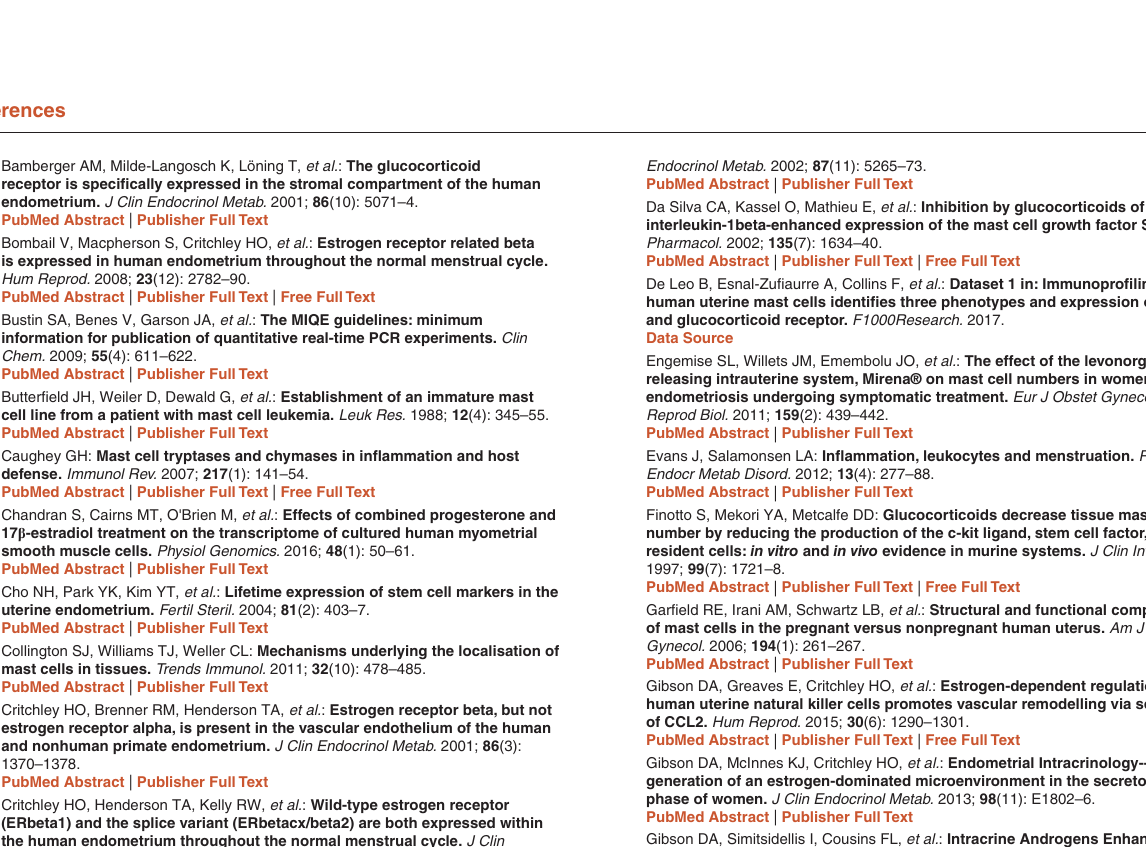
Supplementary Figure 2. Mast cell subtypes and activation state during the early secretory phase. Single fluorescence channels show the different mast cell subtypes in a uterine full thickness section during the early secretory phase. Myometrial compartment shows three different mast cell subtypes: tryptase single positive, chymase single positive and tryptase and chymase double positive. Basal endometrial mast cells are tryptase single positive and double positive, instead functional endometrium MCs are fewer in number and show a chymase negative phenotype. MCs during the early secretory phase appeared to be activated, releasing both proteases from the cytoplasm. (n=4) (White triangles: MCTC cells; white Vs: MCT cells; white arrows: MCC cells). Click here to access the data. Supplementary Figure 3. Mast cell subtypes and activation state during the late secretory phase. During the late secretory phase, MCs are identified as tryptase single positive and weakly double positive (MCTC). In both the endometrial layers MCs showed a strong tryptase only phenotype. MCs during the late secretory phase appeared to be activated only in the myometrial compartment, releasing tryptase and retaining chymase in the cytoplasm. (n=3) (White triangles: MCTC cells; white Vs: MCT cells). Click here to access the data. Supplementary Figure 4. Immunoexpression of ERalpha (ER α ) was detected in multiple cell types within the endometrium and myometrium but not in the nuclei of tryptase-positive mast cells (MCs). Double immunofluorescence showed no ER α immunoex- pression (red staining) in the nuclei of uterine MCs (green staining). MCs were noted to be immunonegative in all uterine layers and across the phases of the menstrual cycle. Myometrial, stromal andepithelial cells showed expression for ER α , as expected (Proliferative n=5, Secretory n=5).